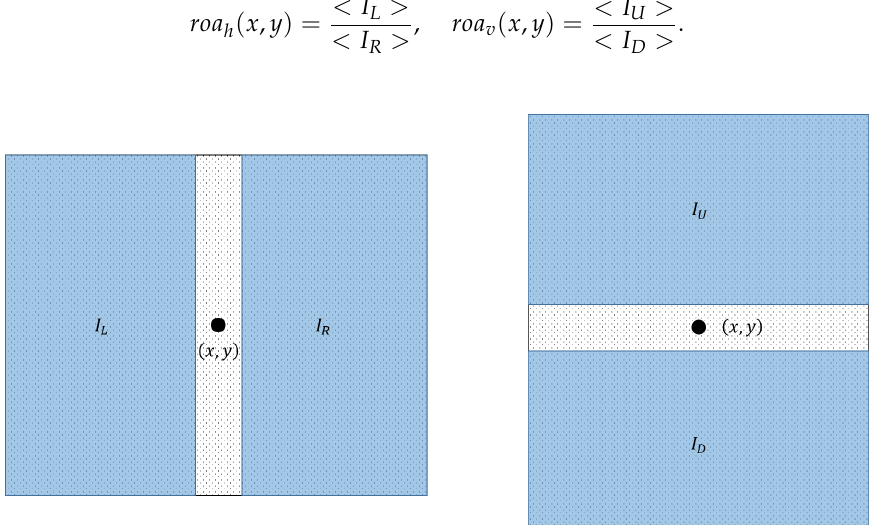
Figure 15. Ratio of average computation along the horizontal and vertical